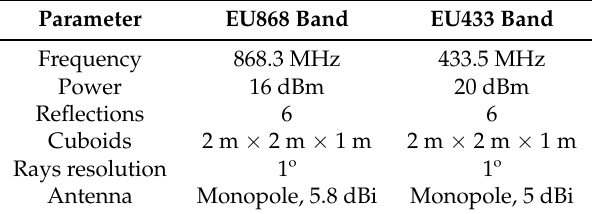
Table 5. 3D-RL simulation parameters.